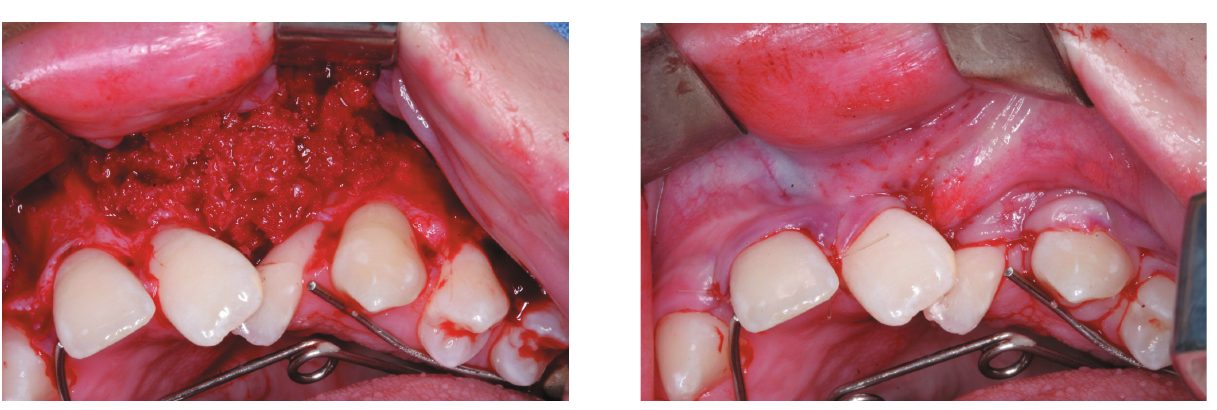
Figure 4- Secondary alveolar bone graft procedure performed in a unilateral cleft (left side). (a) Pre-incision intraoral view. (b) Incision. (c) Alveolar cleft